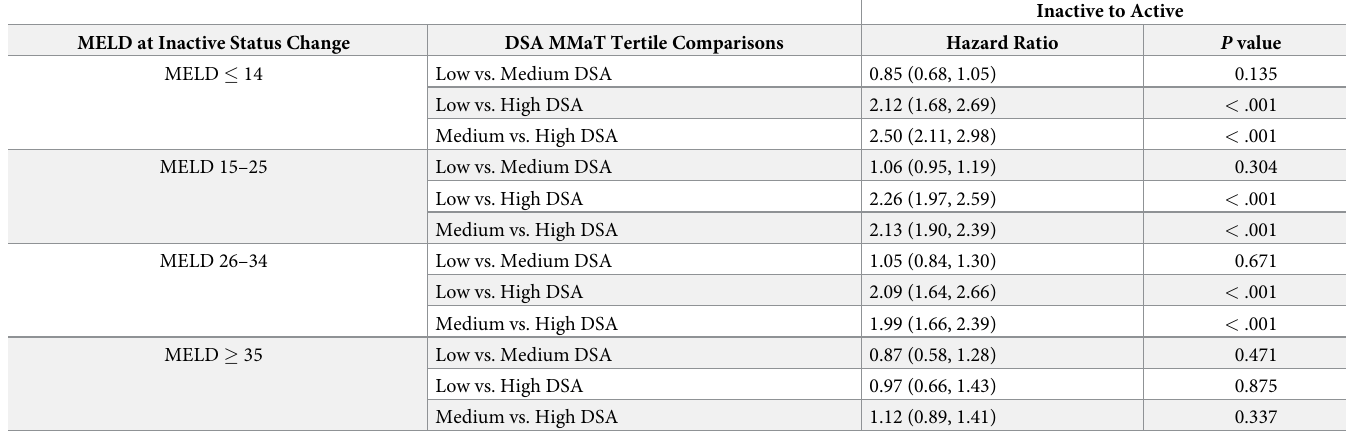
Table 3. Hazard ratios of transition from inactive to active status stratified by DSA MMaT